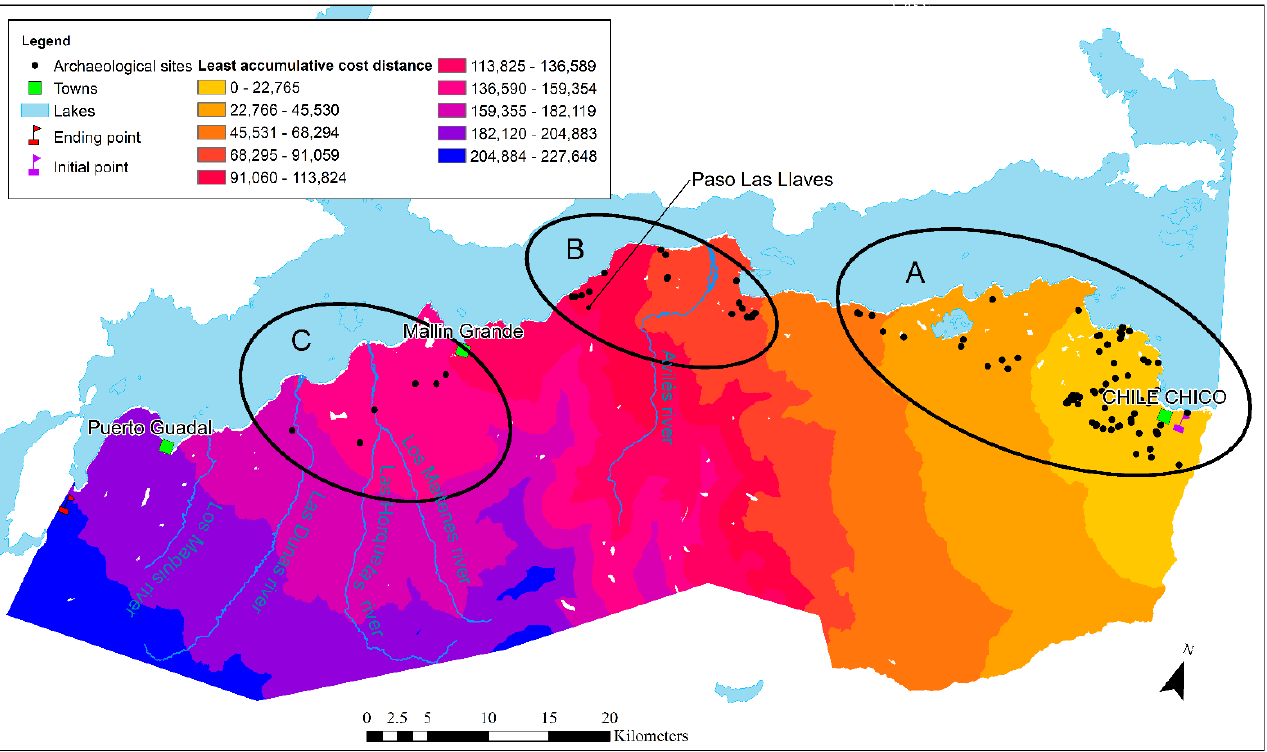
Figure 7. Identification of clusters (black circles) along the southern coast of General Carrera Lake following cluster and least accumulative cost–distance approaches.